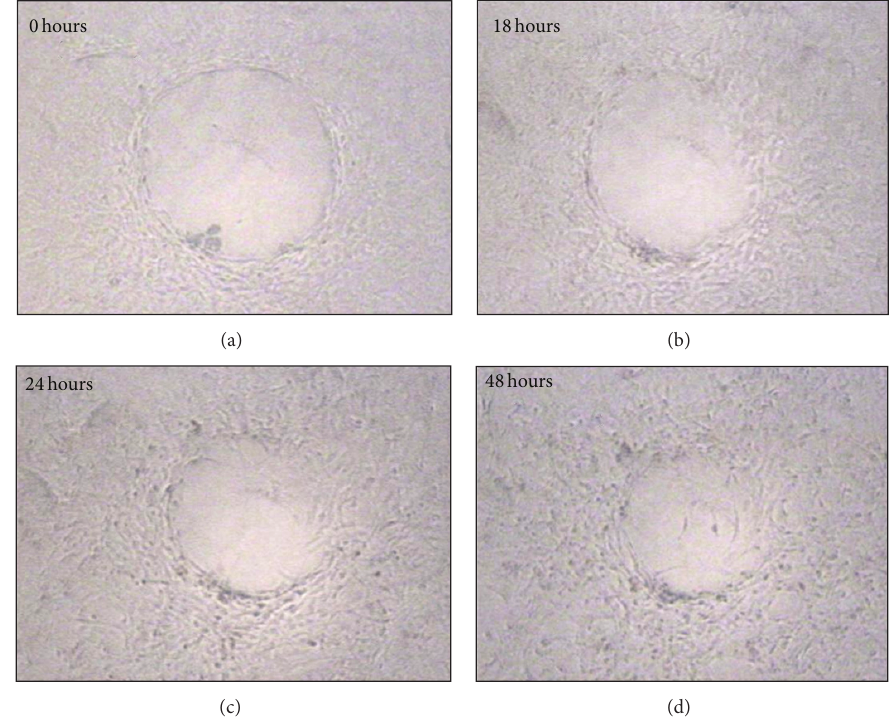
Figure 1: Phase-contrast microphotographs showing the process of wound healing in an ulcer treated with vitamin K 3 1mg/L. Lesion time, 0 hour: in vitro ulcer after being produced in a confluent monolayer; 24 hours fibroblasts migrations was evident; 48 hours: some fibroblast were filling the ulcer